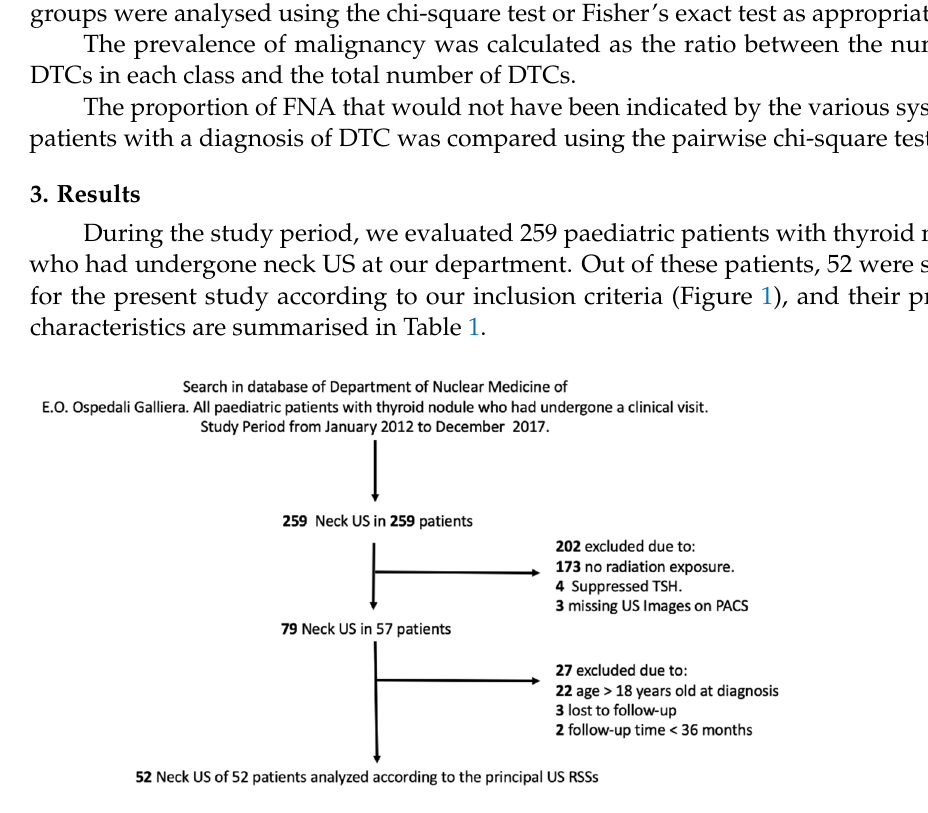
Figure 1. Flow chart illustrating the selection of the patients. Table 1. Characteristics of the patients. Variable Subjects Included (n = 52) Sex Female, n. (%)